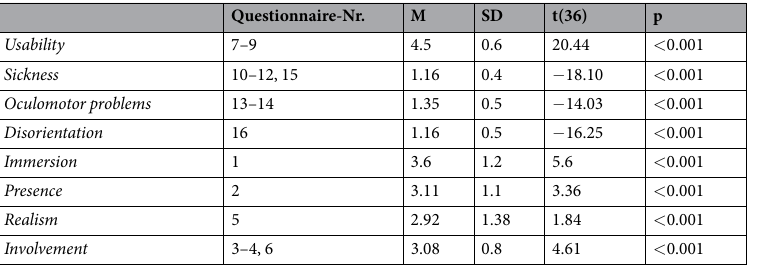
Table 2. Ratings of the questionnaire by using t-tests. The items had a five-point rating scale between one and